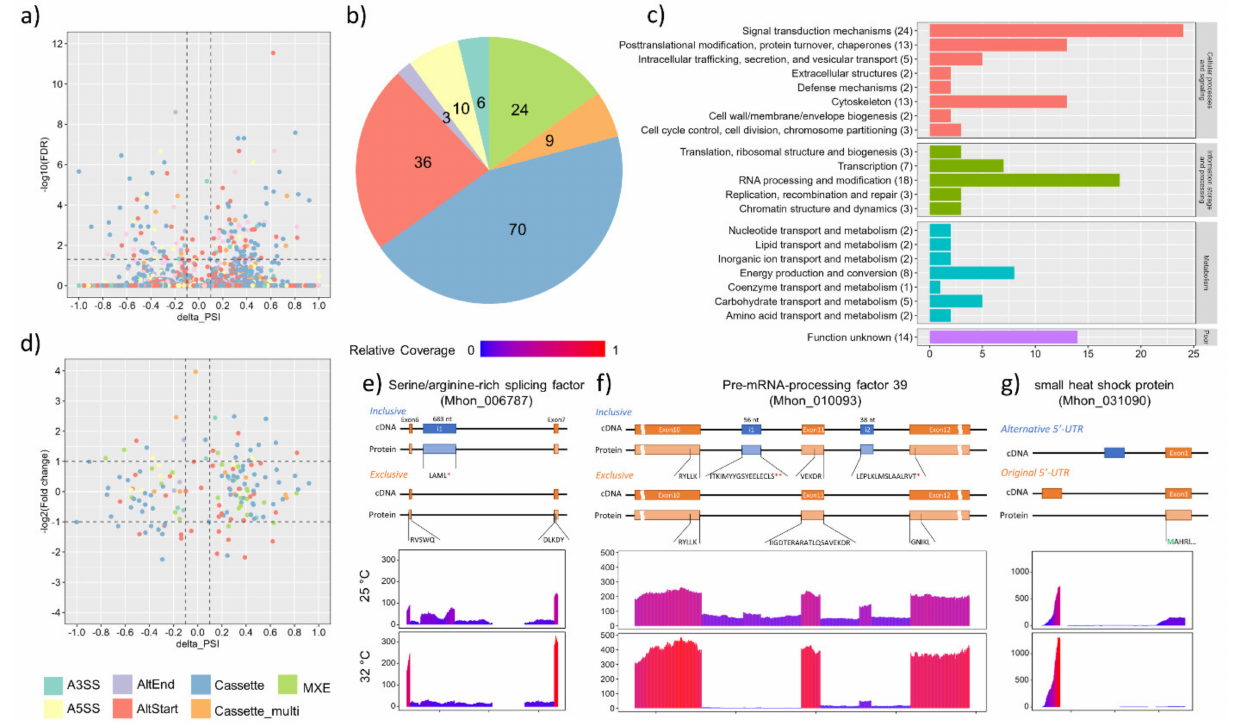
Figure 4. Alternative splicing (AS) events identified from the oysters incubated under ambient (25 ◦ C) and heat-shocked (32 ◦ C) conditions. ( a ) volcano plot showing the delta PSI value of AS candidates; ( b ) number and proportion of different AS types; ( c ) KOG annotation of genes with reliable AS prediction; ( d ) delta PSI value and gene expression fold change of AS genes under two incubation conditions; ( e–g ) alternative splicing patterns of: ( e ) serine/arginine-rich splicing factor Mhon_006787, ( f ) pre-mRNA-processing factor Mhon_010093, and ( g ) small heat shock protein Mhon_031090. Colour legend of AS types is the same for ( a , b , d ). Read count histogram of ( e – g ) is shaded by relative coverage from blue (low) to red